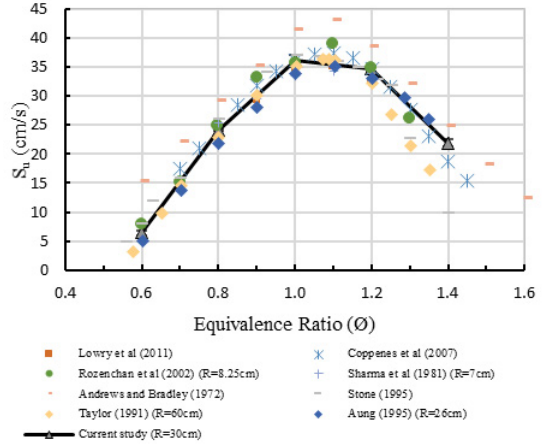
Figure 7. Photographs of flame propagation for M40 at P 0 = 1.0 bar, and different initial